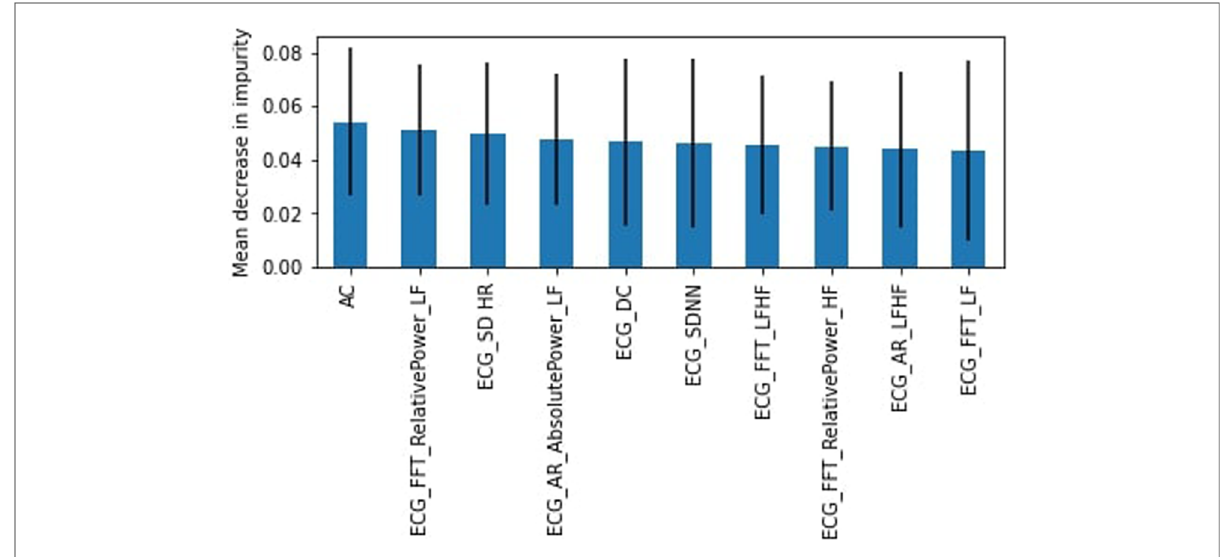
FIGURE 17 RF feature importance, workers.